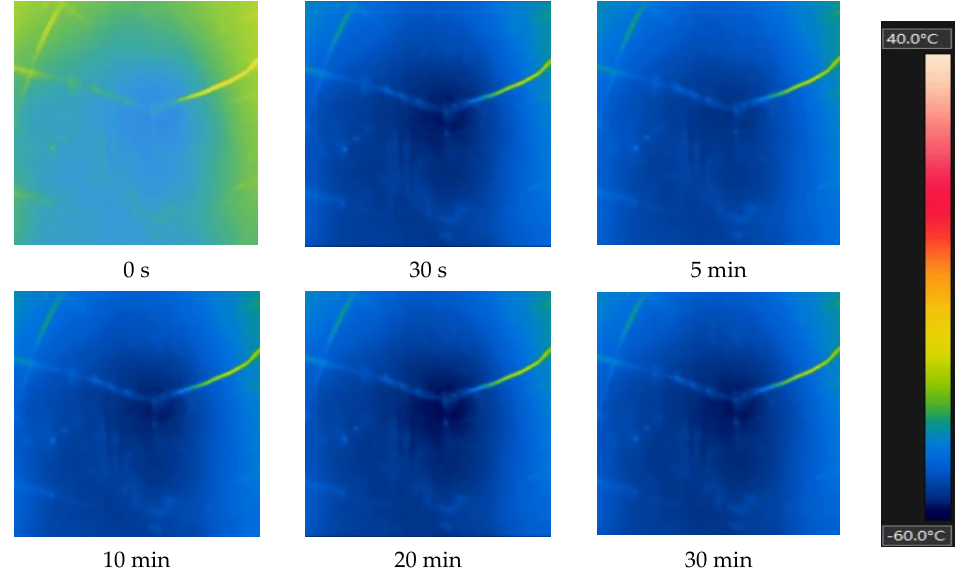
Figure 14. Infrared image of heat flux 850 W/m 2 changing with time.